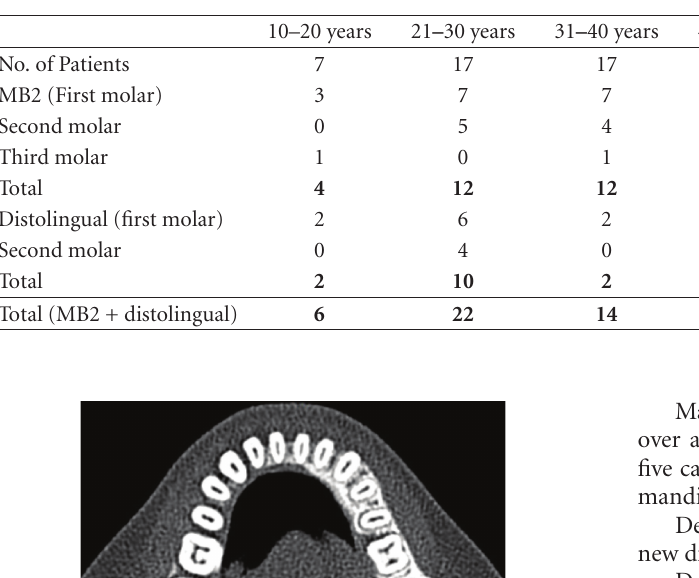
Table 1: Age-wise distribution of MB2 and Distolingual canals.